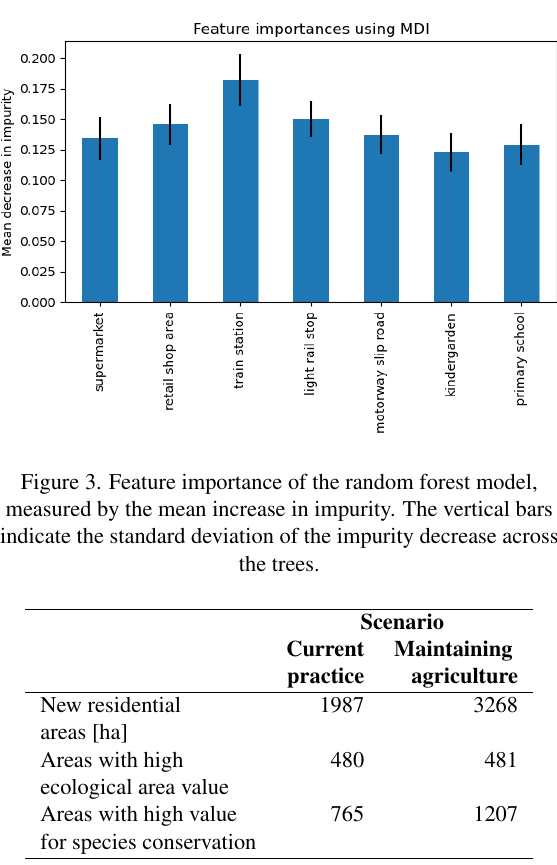
Table 3. Aggregated results for the two scenario runs. Results are aggregated over the whole case study region and over the complete analysis period (2018 -2040). For both ecological value and species conservation the two highest classes (four and five) were aggregated into a ’high value’ class.